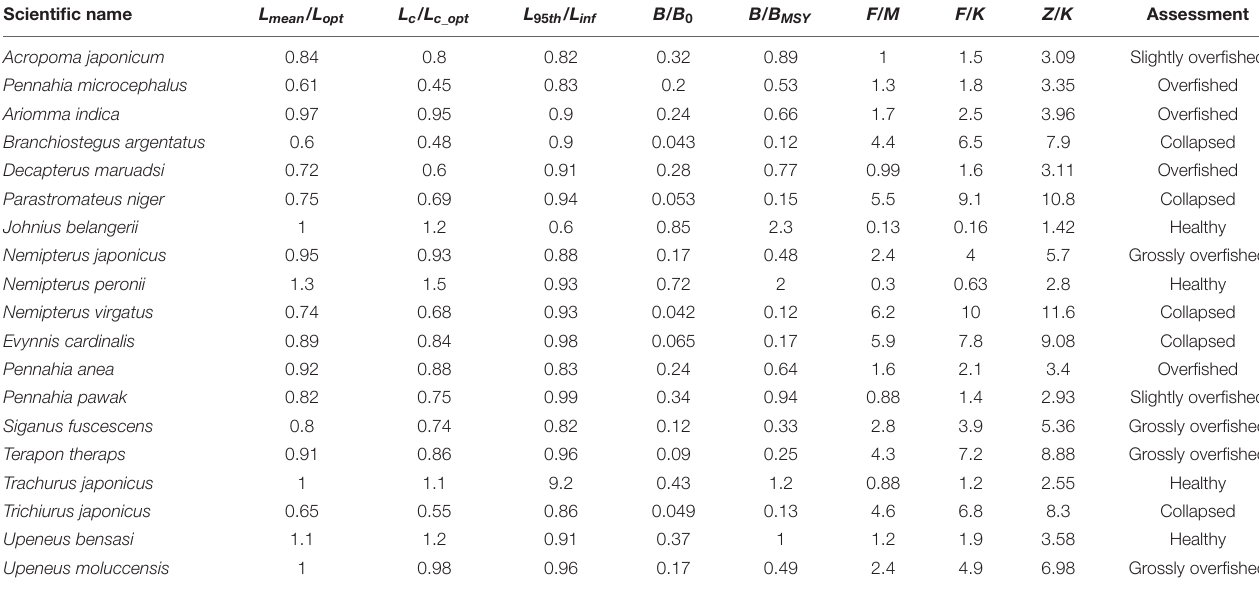
TABLE 3 | Estimates of 19 fish species for 2011 given by